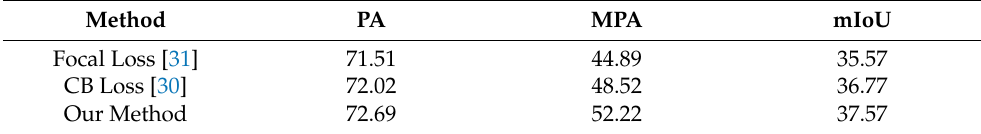
Table 3. Comparison of three method for imbalanced